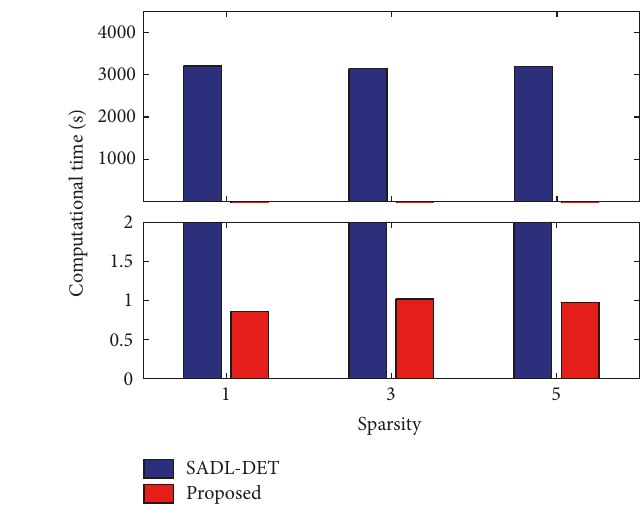
Figure 10: The computational consumption.